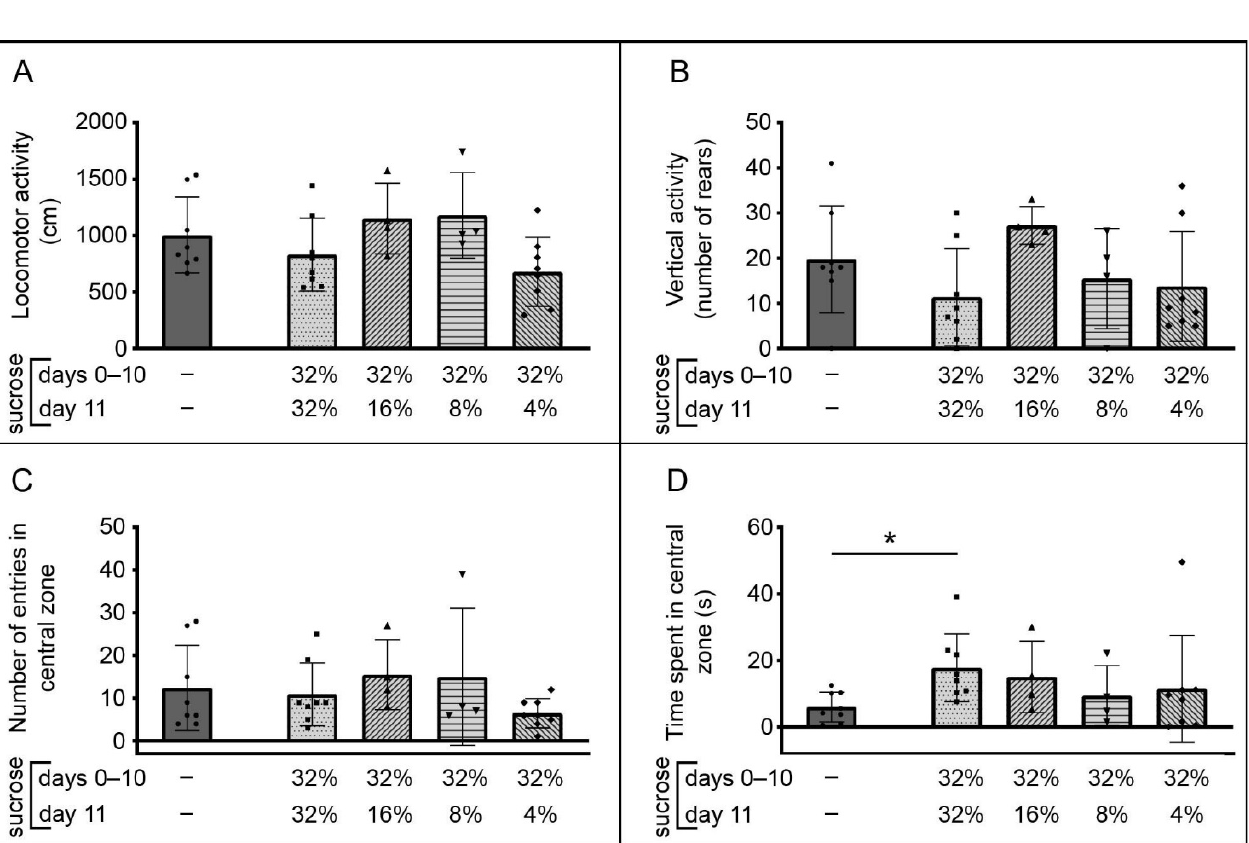
Figure 4. Changes in behavior of adult male C57BL/6J mice in the inescapable novel arena associated with ad libitum access to sucrose solution(s). The data are represented as mean ± SD, with individual data plots along column bars (8 animals per group in all except in 32% → 16% and 32% → 8% downshifted groups, which have 4 animals per group). Locomotor activity ( A ), vertical activity ( B ), number of entries in the central zone of the arena ( C ), and time spent in the central zone of the arena ( D ) were recorded for 5 min, starting immediately after placing the animal in the monitoring arena, with automated collection of behavioral parameters. * p ≤ 0.05 vs. the control group, which had no experience with sucrose, U test followed by Benjamini–Hochberg procedure. The influence of the downshift was not assessed as significant.